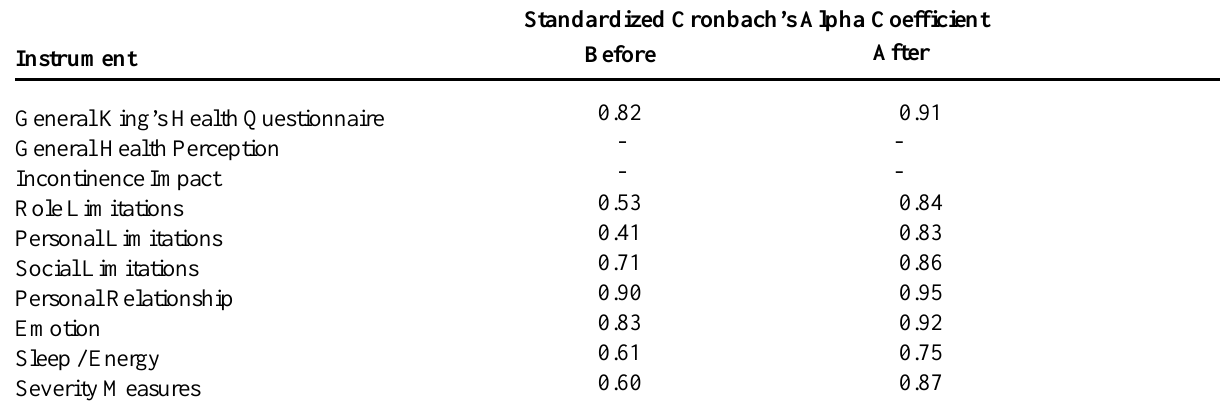
Table 2 – Reliability assessed by means of standardized Cronbach’s alpha before and after treatment, in relation to